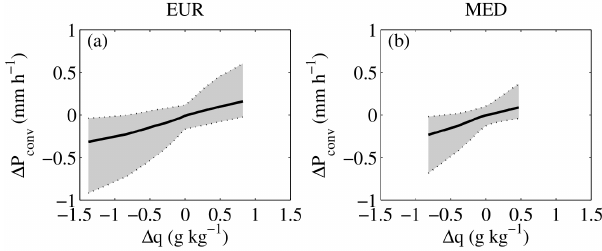
Figure 4. Relative difference between the MAX and MIN simu- lations of continental summer convective ( (cid:49)P conv /P conv , dotted), not convective ( (cid:49)P expl /P expl , dashed), and total ( (cid:49)P tot /P tot , solid) accumulated precipitation as a function of convective precipitation fraction ( P conv /P tot ) over Europe (EUR domain, Fig. 1) (a) and the Mediterranean region (MED domain, Fig. 1) (b) .